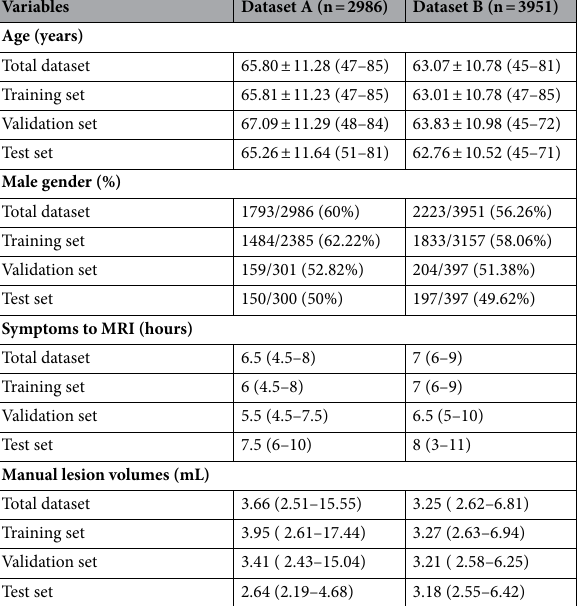
Table 1. The detailed characteristics of the study sample. Continuous variables are presented with the mean ± standard deviations or median and interquartile